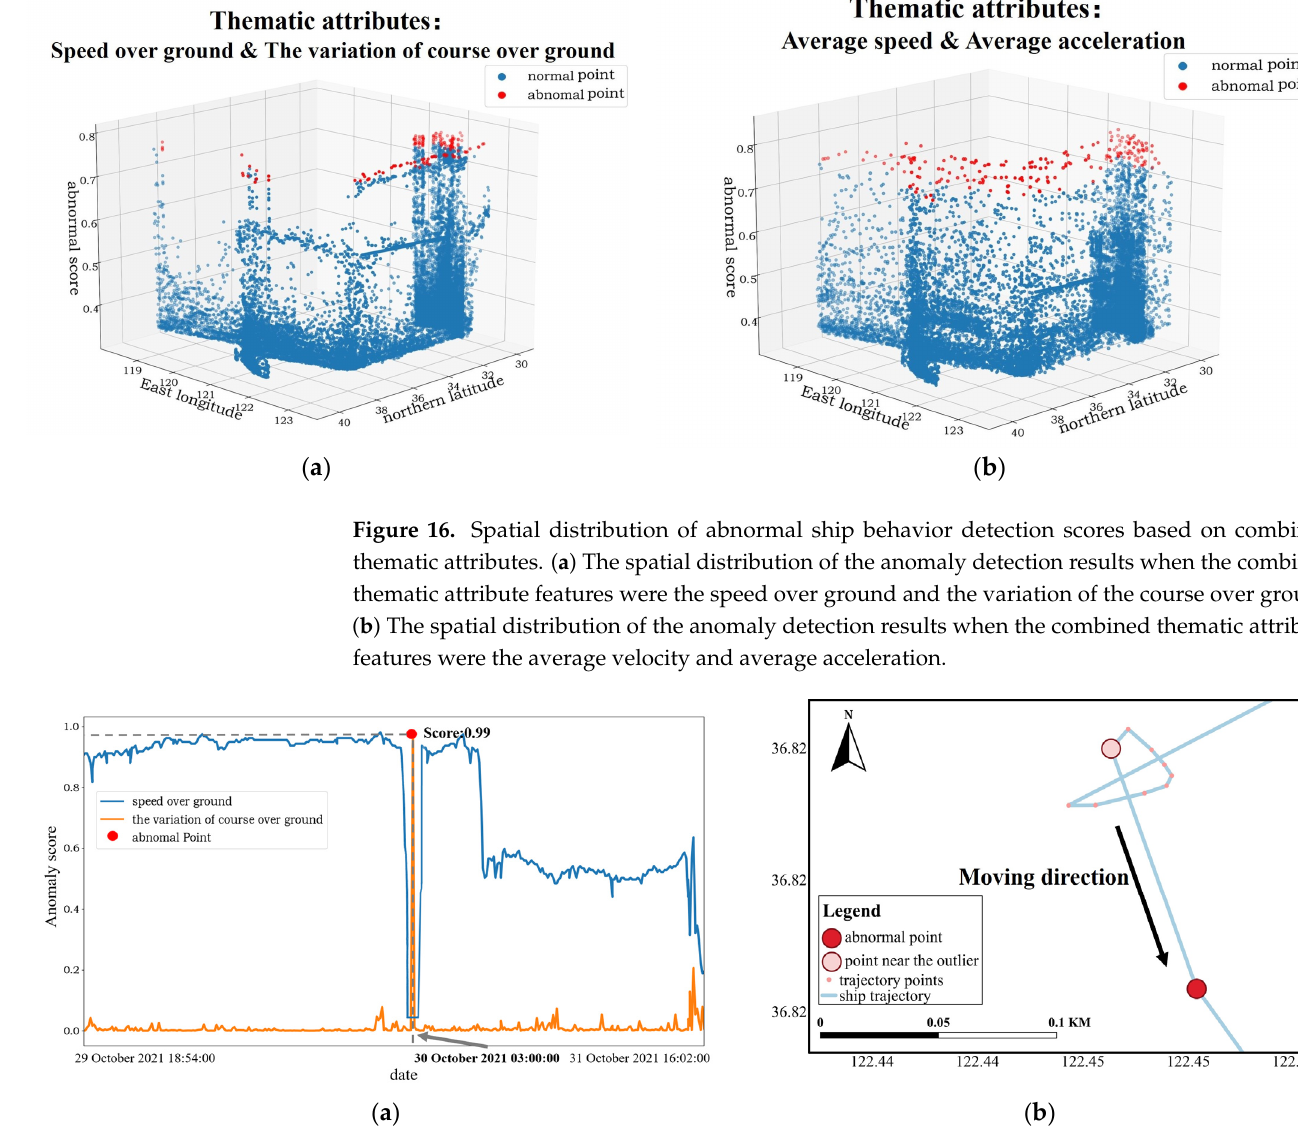
Figure 17. The thematic attribute set is the schematic diagram of abnormal ship point detection with instantaneous features. ( a ) The change over time after normalization of the two thematic attributes. ( b ) The realistic mapping of the high anomaly score points in ( a ) in the geographic environment.